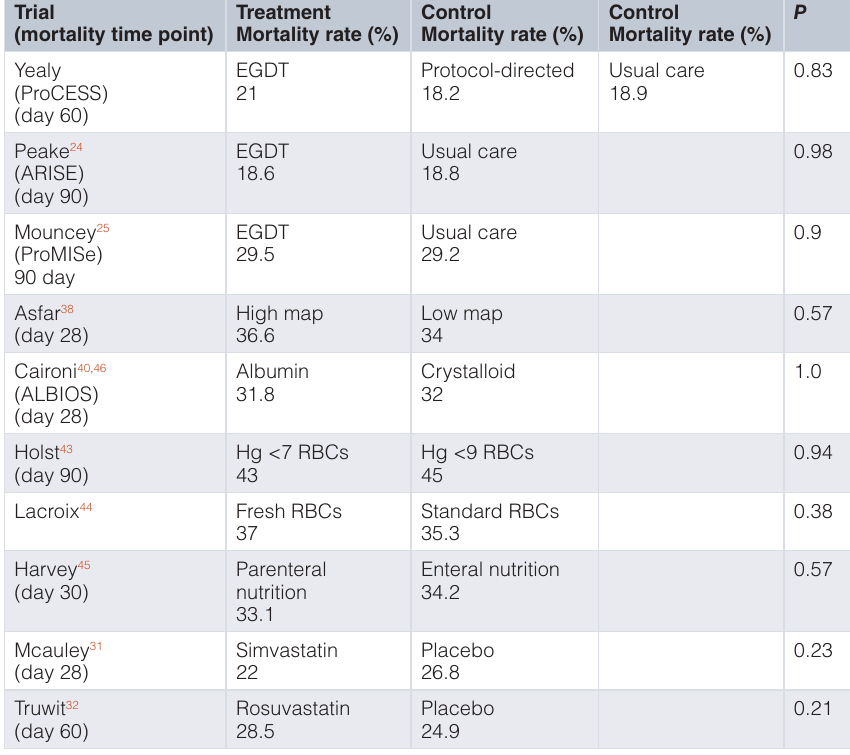
Table 2. Mortality rates of large multicenter pivotal RCTs relevant to severe sepsis, septic shock and acute respiratory distress syndrome (ARDS) published in 2014 and early 2015. Trial Treatment Control (mortality time point) Mortality rate (%) Mortality rate